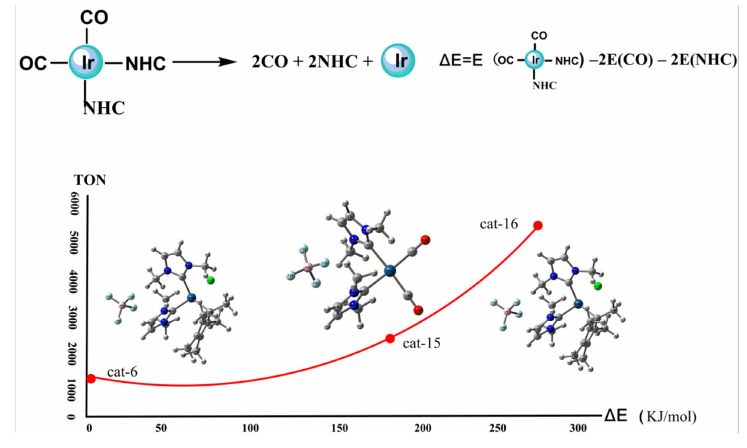
Figure 6. The relationship between binding energy and